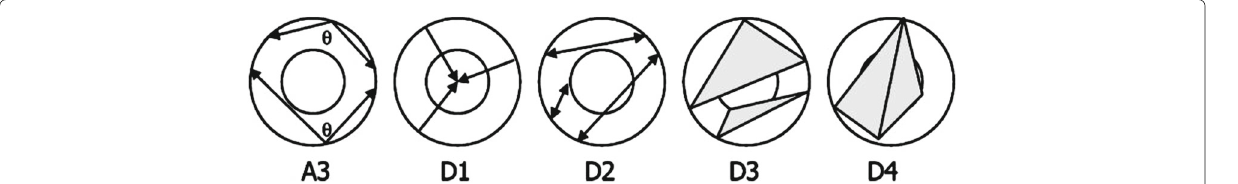
Fig. 3 Shape functions by Osada et al. [21]. All the distances are calculated on Euclidean